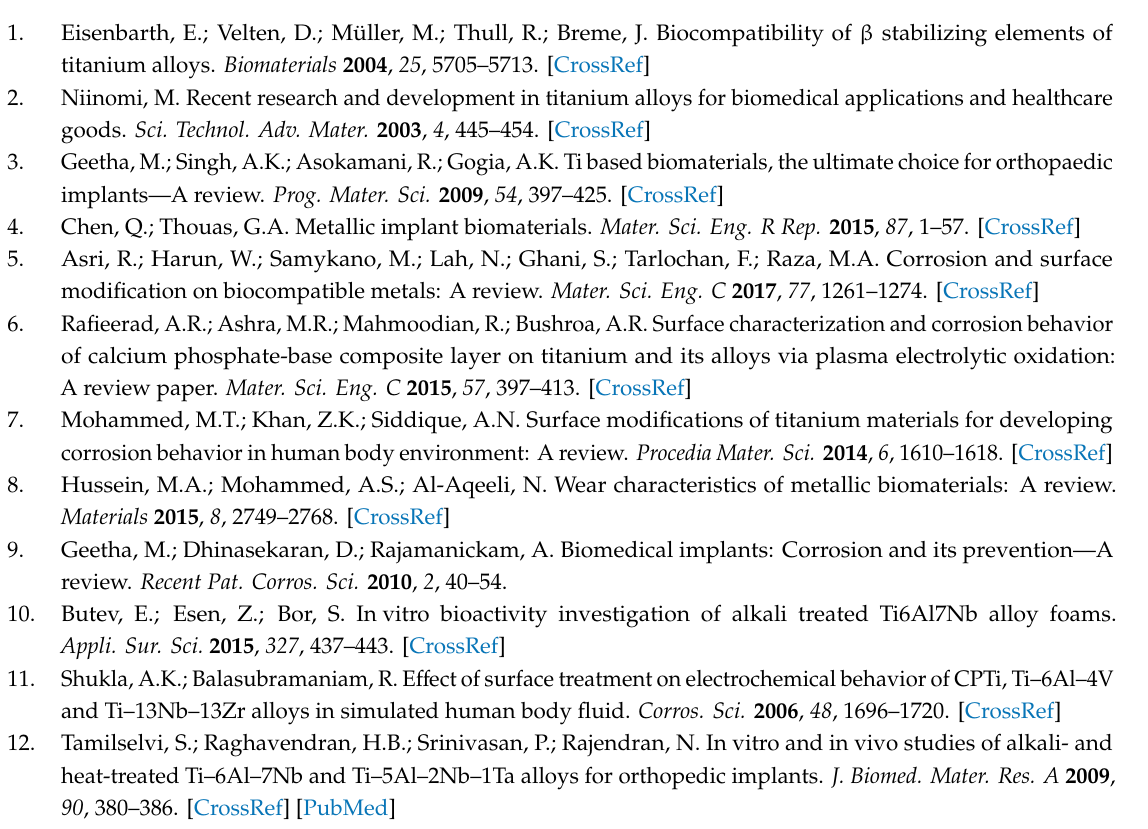
Figure S1: EDS analysis of bare and surface treated TNZ specimens, Table S1: Surface roughness parameters of bare and treated TNZ specimens, Figure S2: LPR curves of (a) Bare, (b) SHT, (c) HPT and (d) SHPT, Figure S3: EIS circuit models of (a) Bare and (b) treated TNZ substrates, Figure S4: EDS results of bare and surface treated